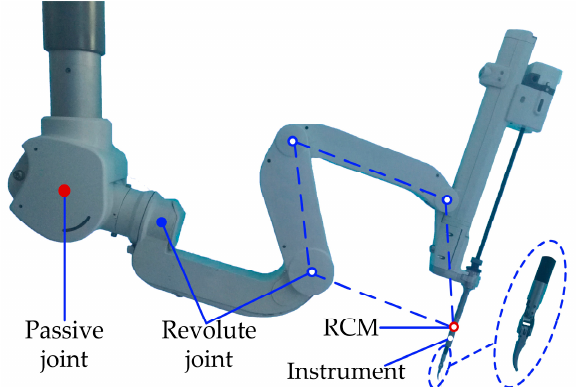
Figure 3. The robotic arm and surgical instrument studied in this paper.